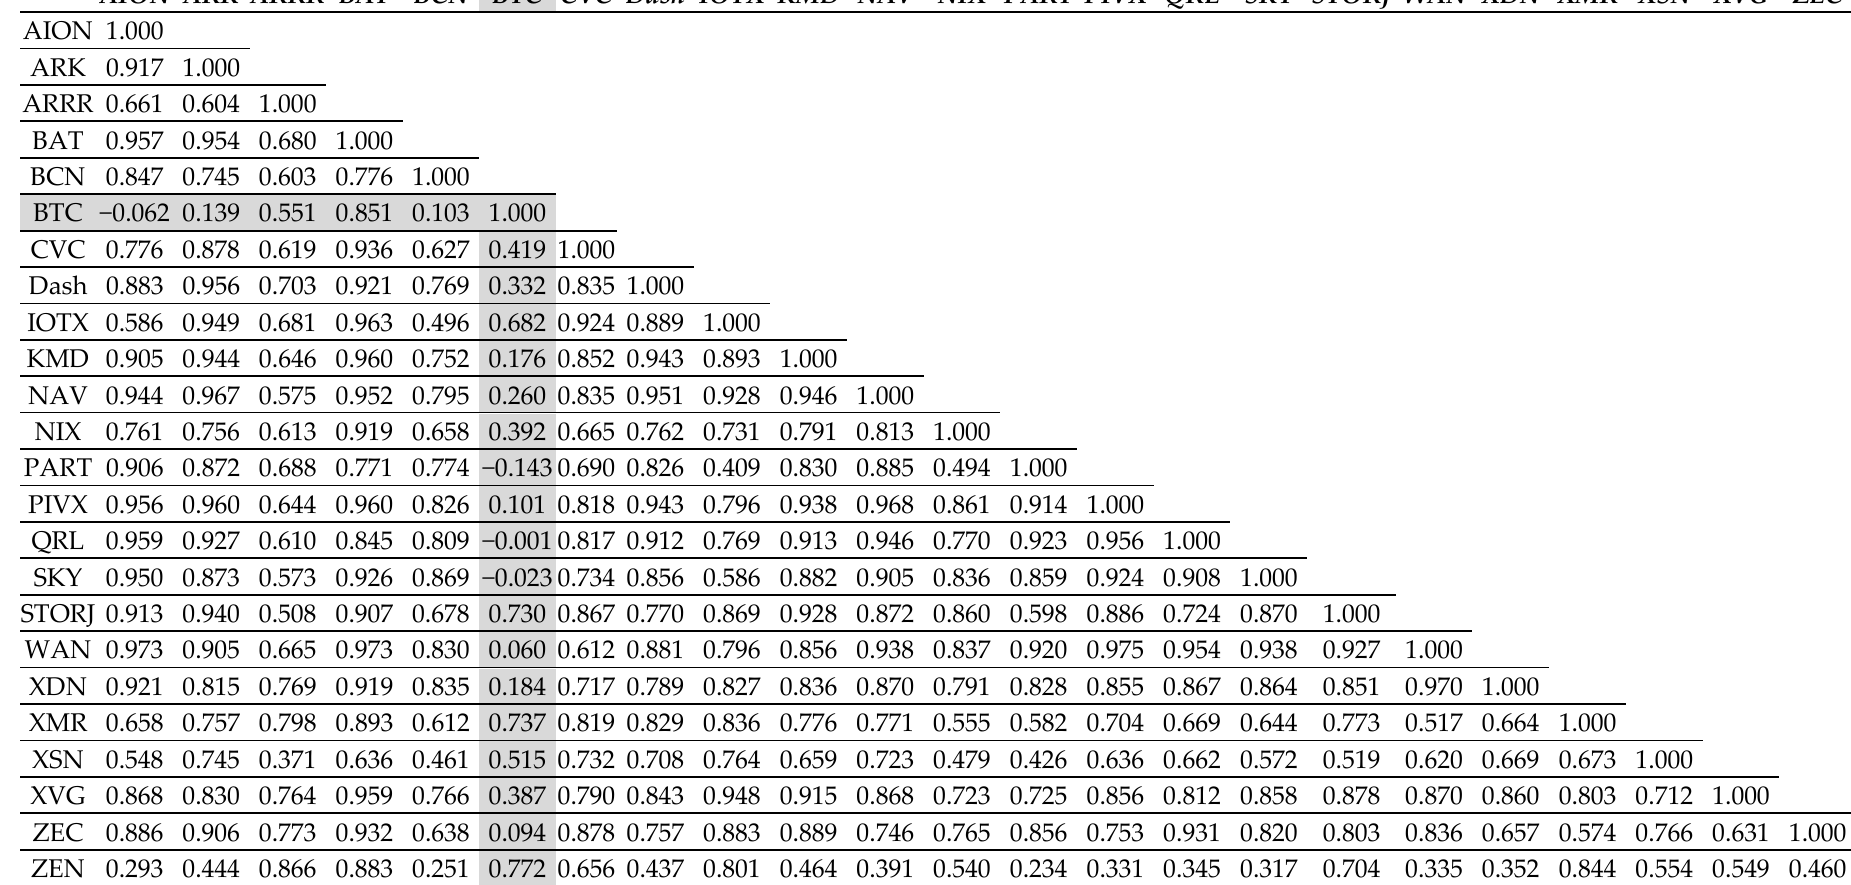
Table 3. Correlation coefficients of analyzed cryptocurrencies in the time period from 17 September 2014 to 18 June 2021 (apart of QRL and SKY, all other privacy coins did have a statistically significant correlation with BTC, which had a p value of <0.05 in AION and <0.01 in the rest of the cryptos).